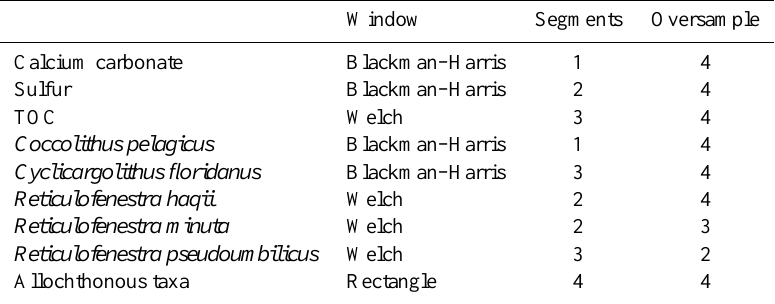
Figure 6. Periodograms of the nine investigated geochemical and paleoecological proxies showing their respective periodicities in millimeters calculated using REDFIT. Black lines indicate the power of the frequency components. Red and orange lines respectively show the 99 and 90% confidence intervals (CI) of the REDFIT analyses. Grey bars represent the reported periodicities of the Lower and Upper Gleissberg cycle, and the Suess/de Vries cycle. Table 2. Overview of the setting used in REDFIT for the nine studied proxies.